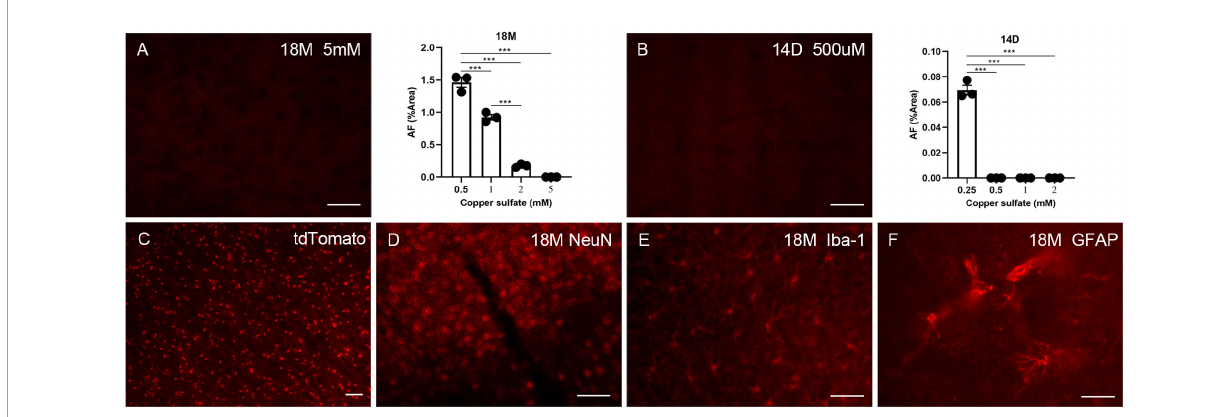
FIGURE4 The effects of copper sulfate pre-treatment on brain AF. Effect of different concentrations of copper sulfate on the amount of AF elimination in the aged brain (18M), and representative image of complete elimination of AF at 5 mM (A) . Effect of different concentrations of copper sulfate on the amount of AF elimination in the 14 days of injection in lipopolysaccharide (LPS)-induced young brains (14D), and representative image of complete elimination of AF as low as 500 µ M (B) . Red fluorescent protein (RFP) tdTomato was not affected by copper sulfate treatment (C) . Brain sections from aged mice (18M) were pre-treated using 5 mM copper sulfate for 1.5 h, and immunofluorescence staining was performed for detecting NeuN (D) , Iba-1 (E) , and GFAP (F) . The scale bars represent 20 µ m. Significance analysis with one-way analyses of variance (ANOVA) followed by Tukey’s multiple comparisons test. *** p <